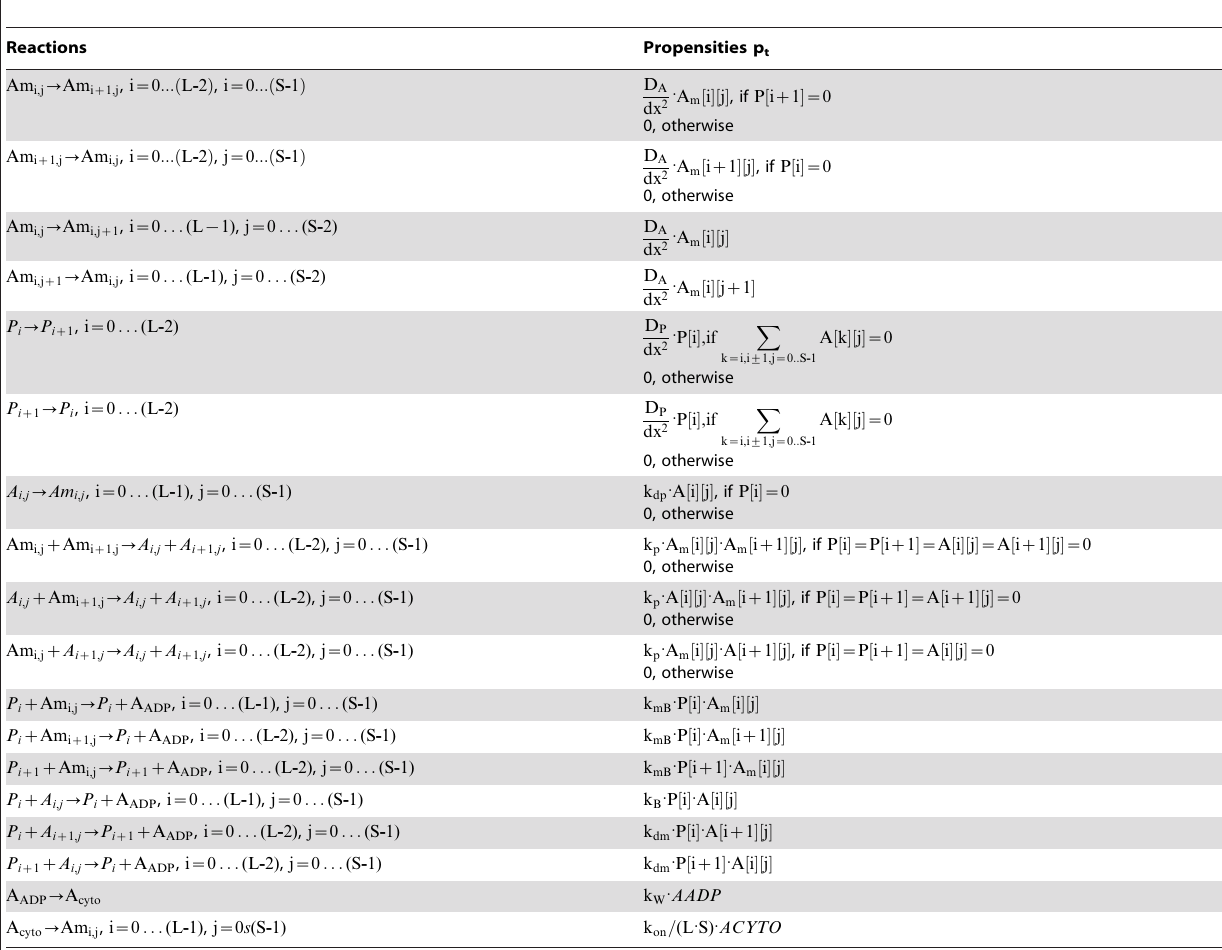
Table 3. Reactions and propensities used in the directed motion models.